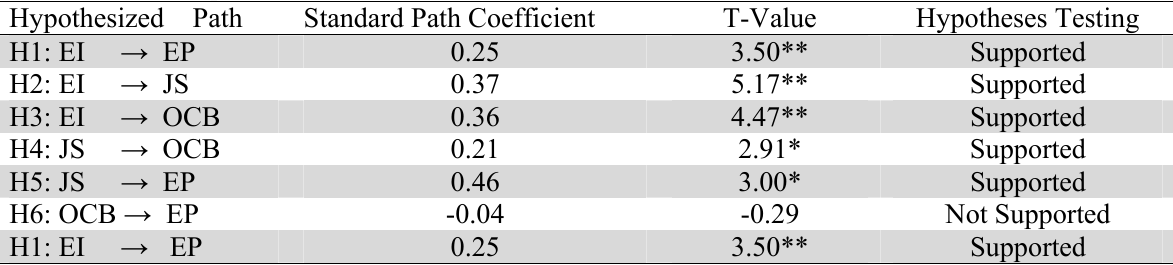
Results of the Proposed Model Hypothesized Path Standard Path Coefficient T-Value Hypotheses